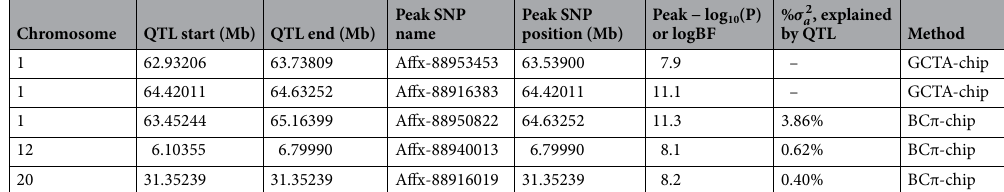
Table 4. Detection of QTLs associated with spontaneous maleness in XX-rainbow trout with GCTA-chip and BCπ-chip methods. The QTL start and end positions correspond to the confidence and credibility intervals for GCTA-chip and BCπ-chip respectively. For BCπ-chip, the logBF is calculated as twice the natural logarithm of Bayes Factor. % σ 2 a : proportion of total genetic variance explained by the QTL calculated as the sum of the variance estimated by the BCπ-chip analysis of all SNPs within the QTL credibility interval.